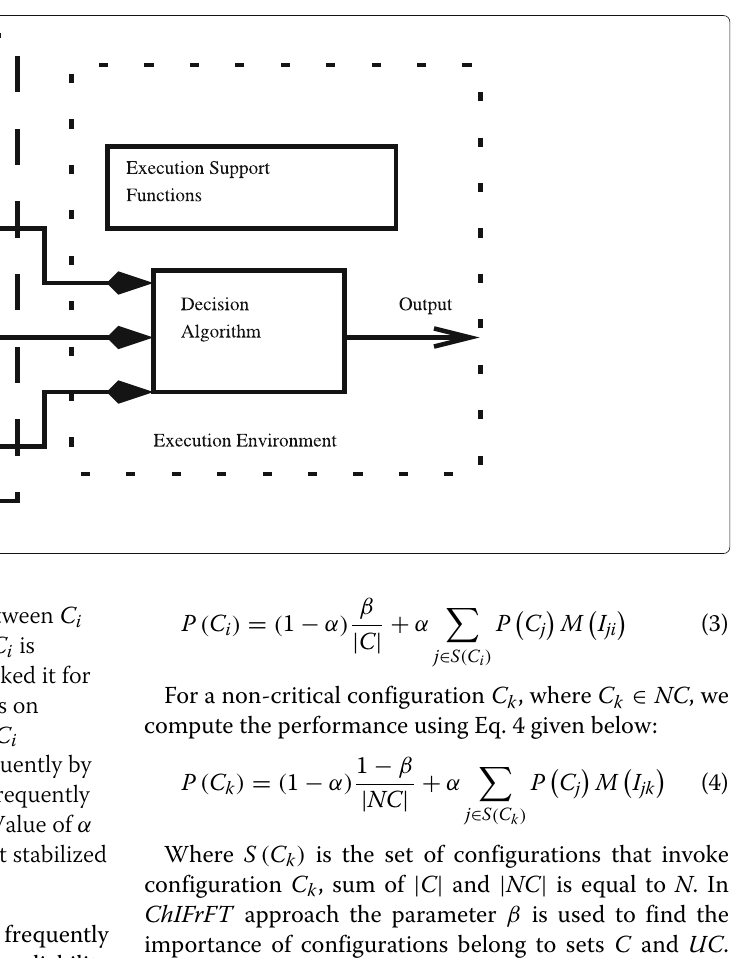
Fig. 3 N-Version programming